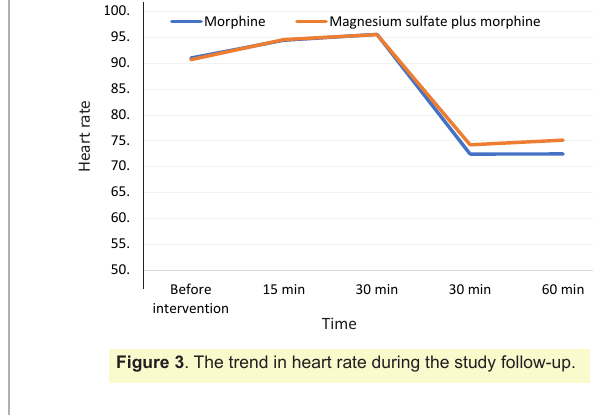
Figure 5 . The trend in mean diastolic blood pressure during the study follow-up.